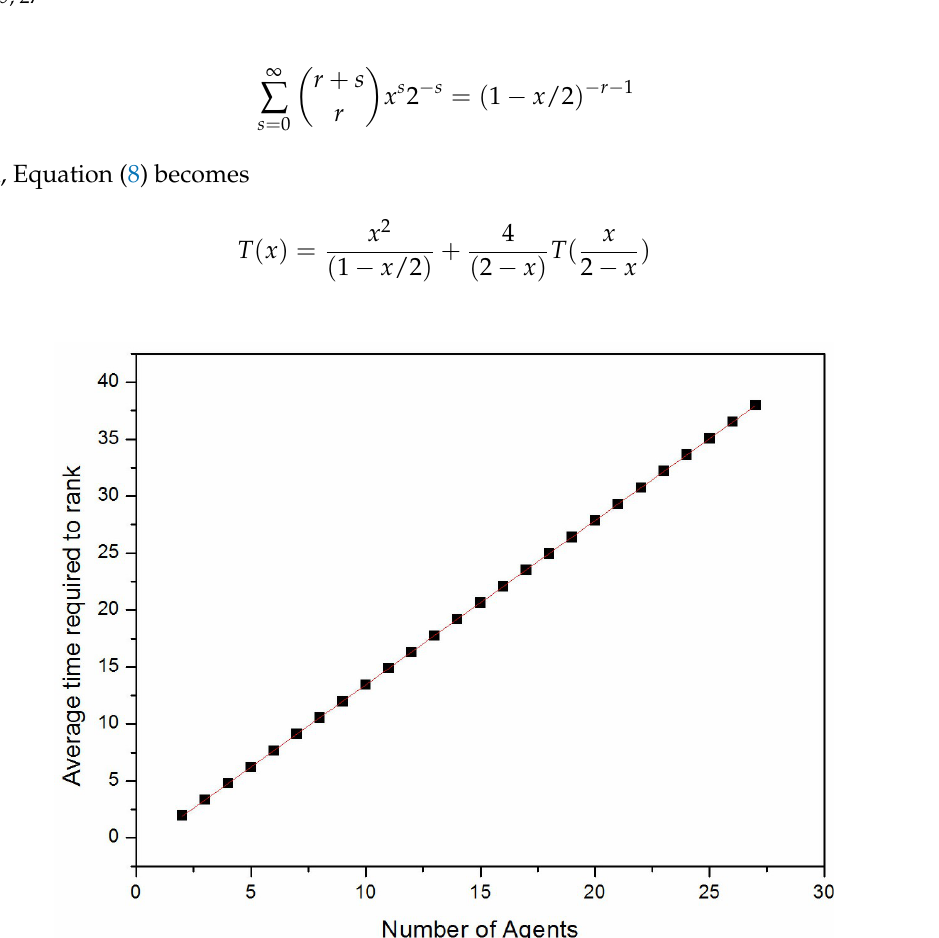
Figure 2. Numerically determined exact values of T n for n ≤ 30. The equation of the approximate linear fit here is y = 1.4449 x −